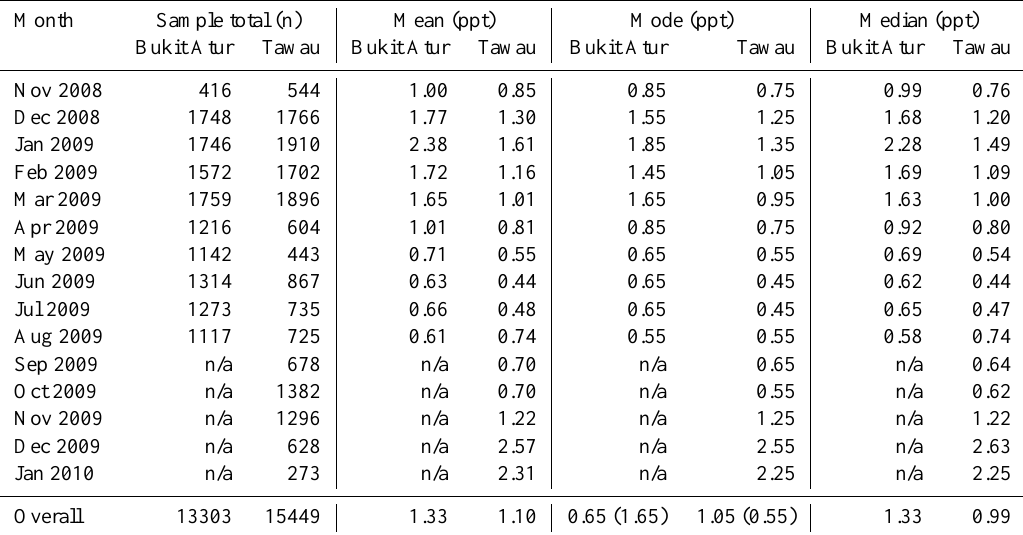
Table 3a. Statistical summary of our observations at Bukit Atur and Tawau: monthly and overall mean, mode and median values for the mixing ratios of (a) C 2 Cl 4 , (b) CHBr 3 , (c) CH 2 Br 2 and (d) CH 3 I. Table 3c also shows the R 2 value for the correlation between CH 2 Br ∗ CHBr 3 for each month; the four strongest correlations are shown in bold; and all correlations give a positive slope except June 2009 at Tawau (shown in italics). The total sample number varies between months and between sites due to differences in chromatogram cycle times and periods of instrument downtime. Modal values are based on a bin width of 0.1ppt. For CH 2 Br ∗ low as we are only able to use about 1 in 10 sample chromatograms for reliable quantification. The overall C 2 Cl 4 distribution at both sites is distinctly bi-modal; the secondary mode is shown in parentheses. n/a means no data available. Statistical summary for C 2 Cl 4 at Bukit Atur and